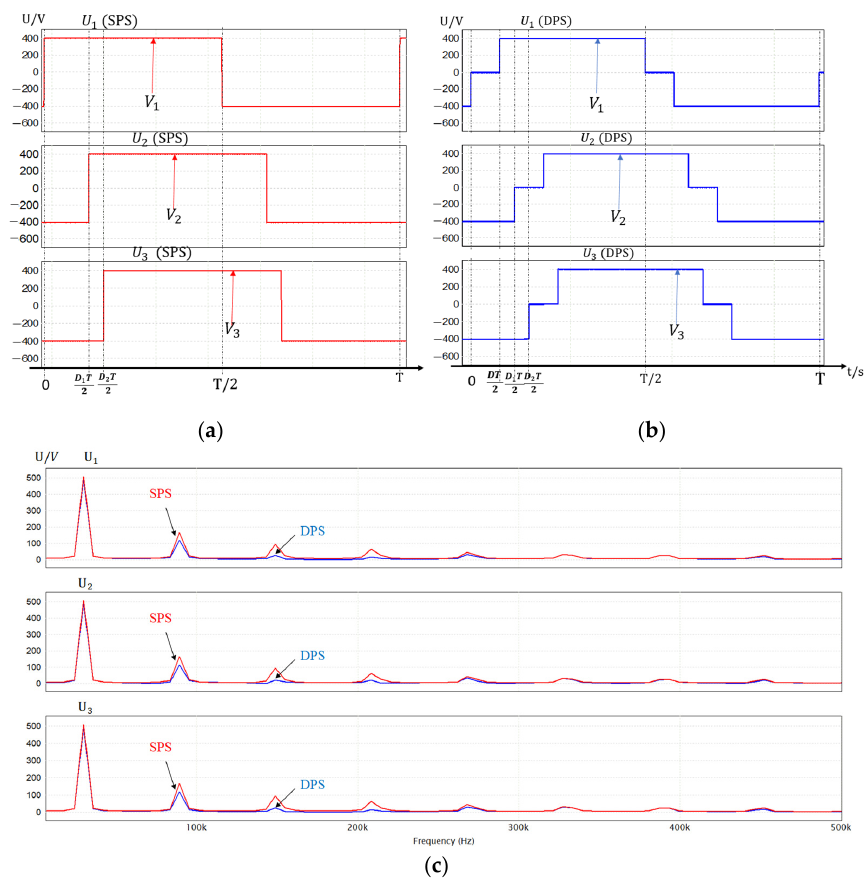
Figure 5. Transformer voltages ( a ) SPS control, ( b ) DPS control, ( c ) frequency response.